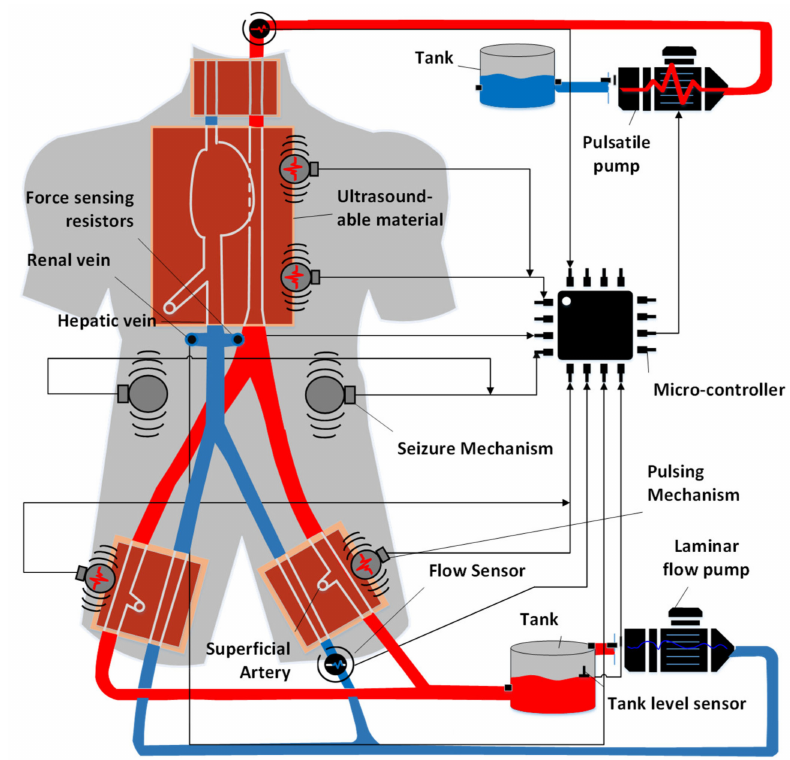
Figure 21. Overall design of the case study.